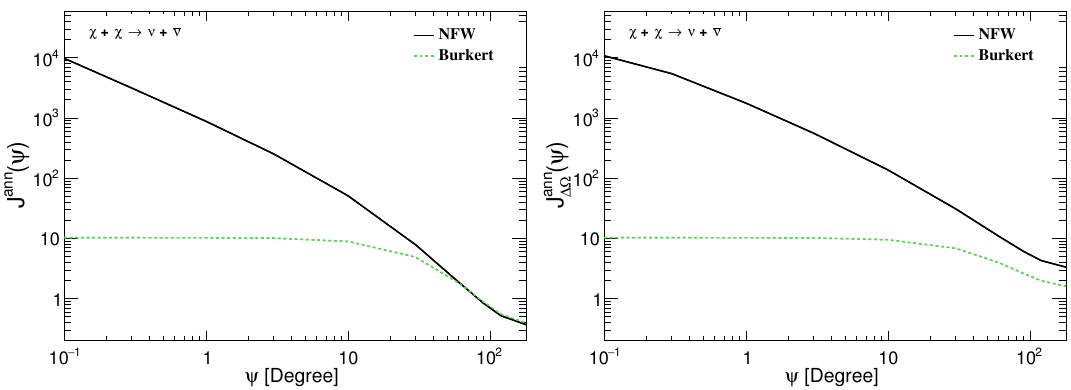
Figure 2. The value of J ann ( ) (see eq. (2.3)) and its average ( J ann ( )) over solid angle (cid:1)(cid:10) (cid:1)(cid:10) = 2 (cid:25) (1 (cid:0) cos ) (see eq. (2.5)) are shown in left and right panels. In both the panels, black solid and green dashed lines present the corresponding quantities for the NFW and Burkert pro(cid:12)les respectively. We use J ann ( = 180 (cid:14) ) for the di(cid:11)use dark matter analysis, which has values 3.33 (cid:1)(cid:10) and 1.6 for the NFW and Burkert pro(cid:12)les respectively.